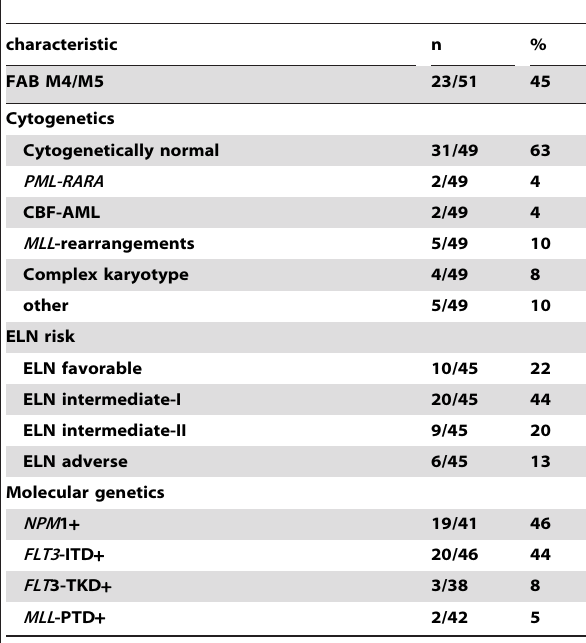
Table 2. Morphologic, cytogenetic and molecular characteristics of patients with WBC $ 100